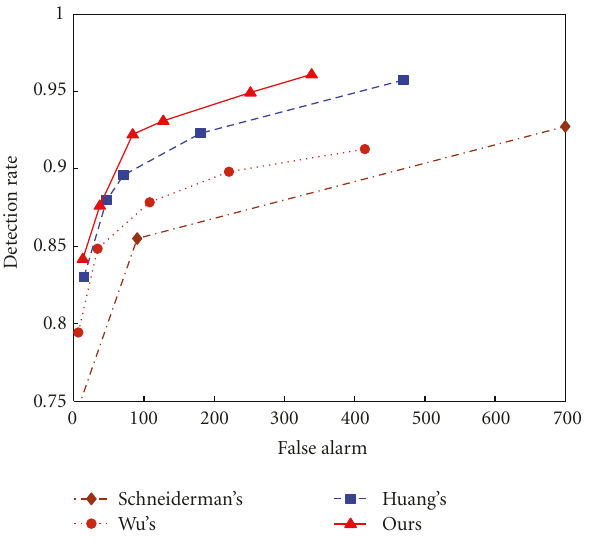
Figure 15: ROC curves on CMU profile set.